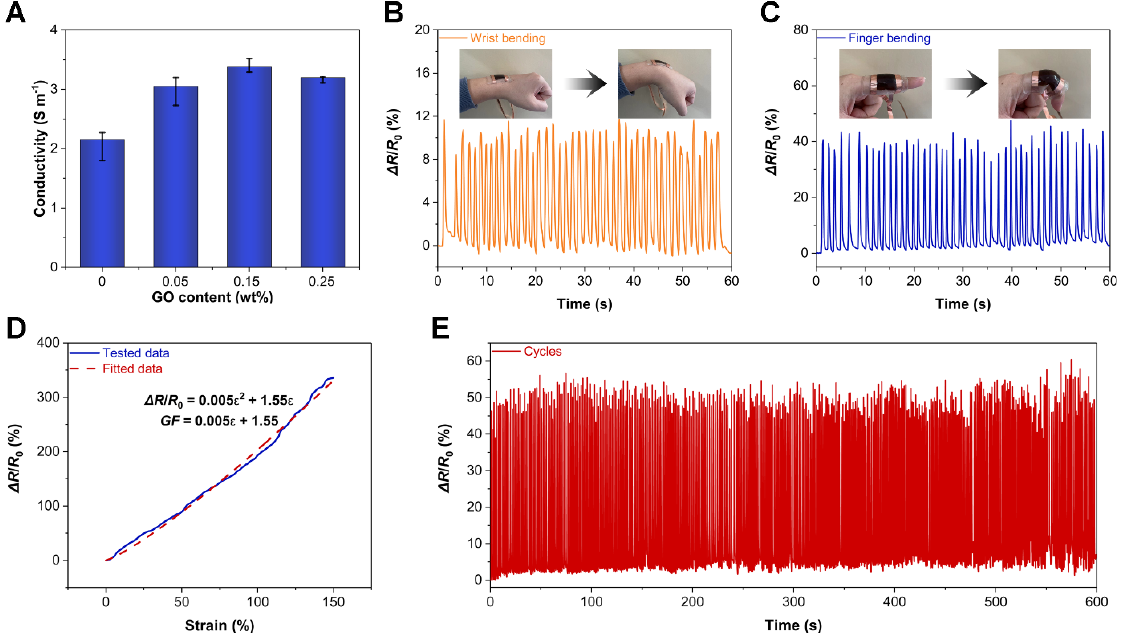
Figure 6. ( A ) Ionic conductivities of PVA/GO hydrogels with different GO contents. ( B ) The PVA/GO strain sensor responding to the bending motion of the wrist in real-time. ( C ) The PVA/GO strain sensor responding to the bending motion of the finger in real-time. ( D ) Sensitivity of the PVA/GO strain sensor. ( E ) Cyclic working stability of the PVA/GO strain sensor.